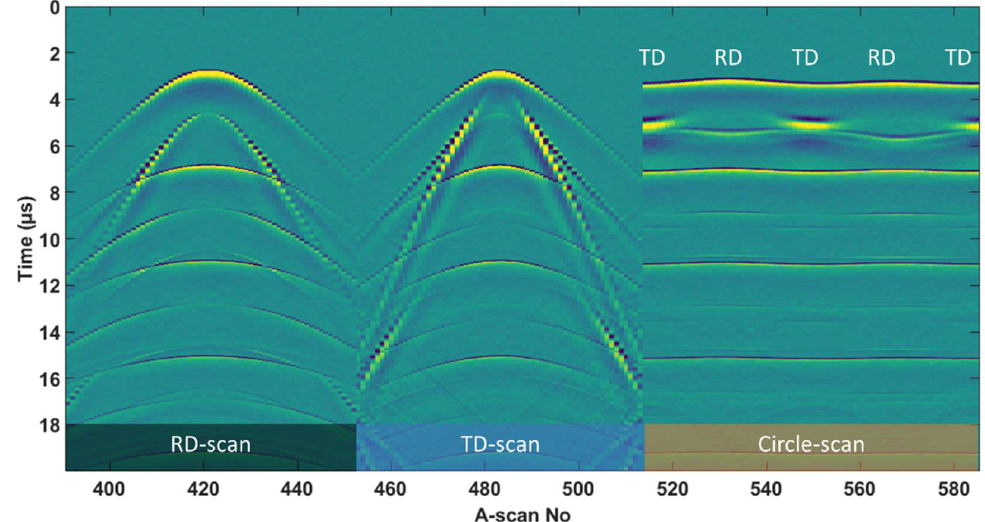
Figure 6. Typical B-scans for measurements with a cross extending ± 3 times the plate thickness together with one circle at a radius of 0.7 × thickness.